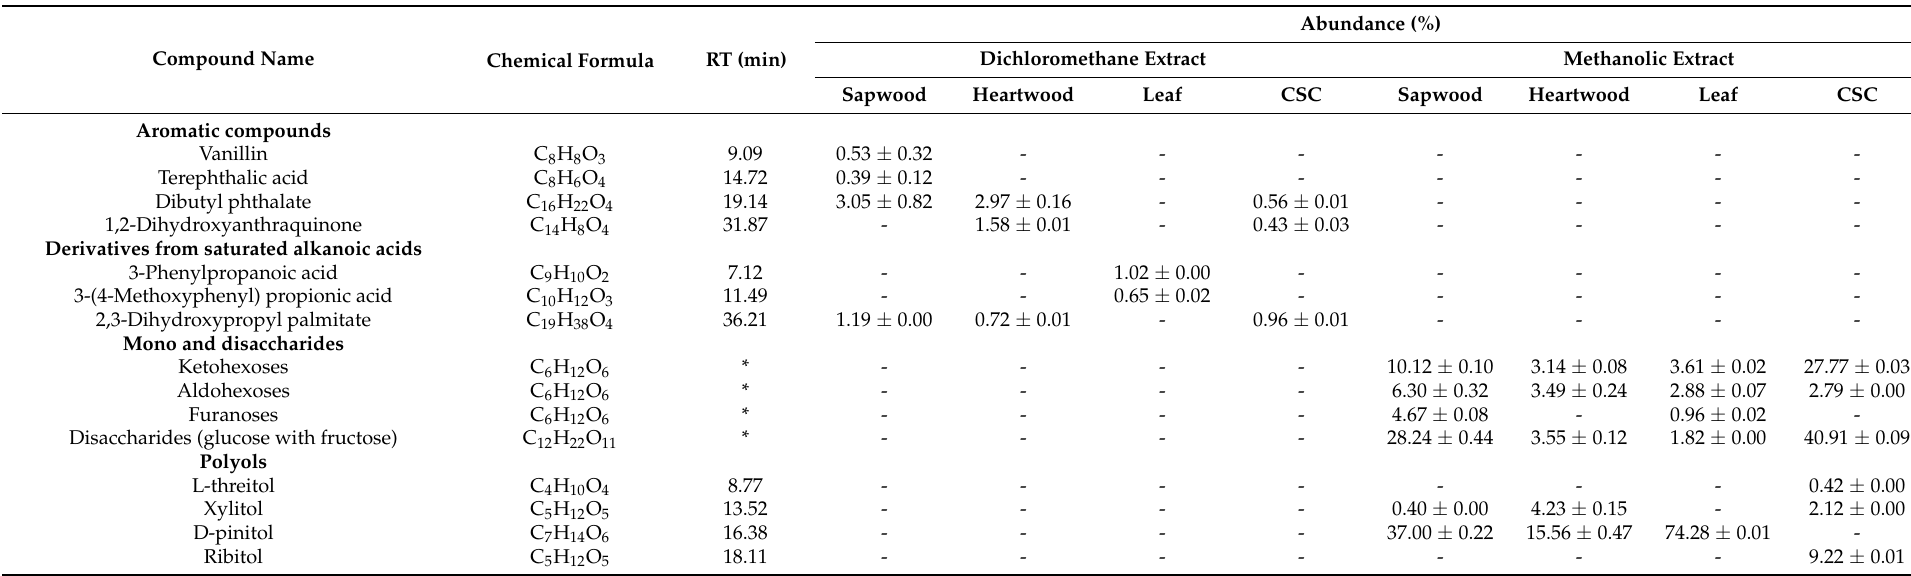
Table 4. Chemical constituents of the Dichloromethane and methanolic extracts of cell suspension culture (CSC) and plant of Eysenhardtia platycarpa identified by